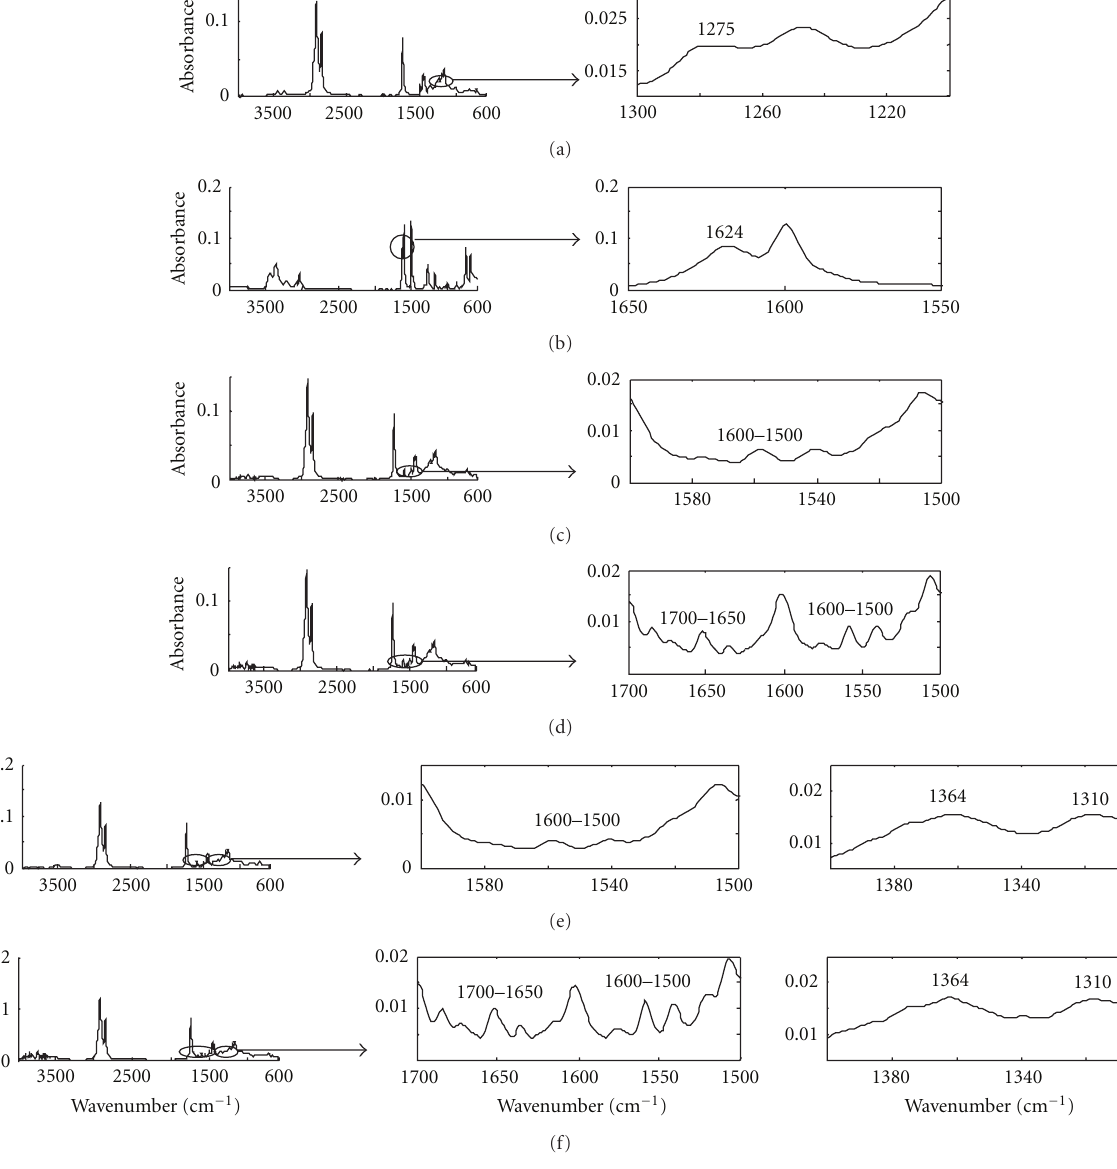
Figure 2: Spectral profiles of the species recovered by MCR-ALS: (a) EMO; (b) aniline; (c) secondary amine (SA); (d) amide (AD1); (e) tertiary amine (TA); (f) tertiary amine